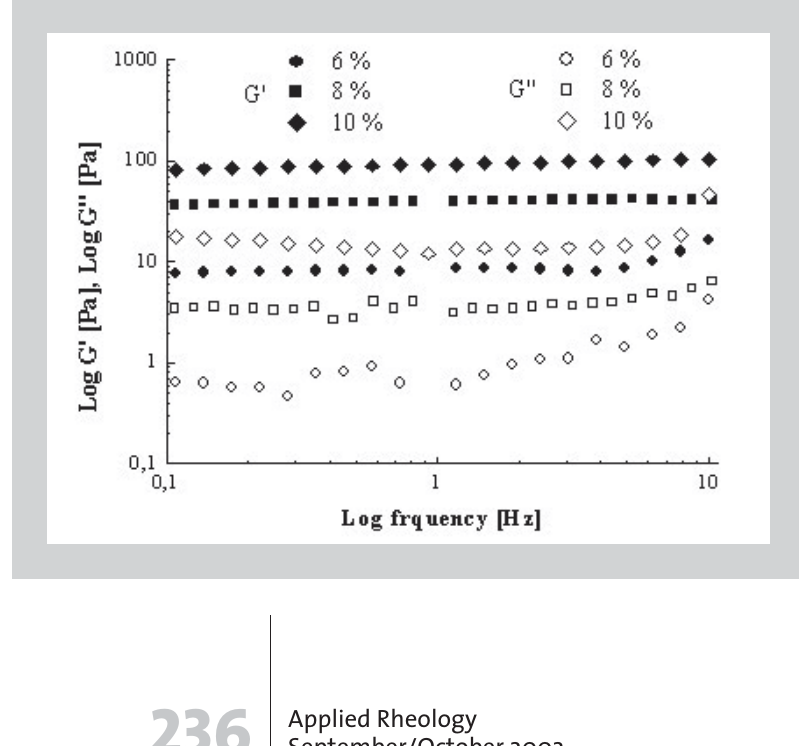
Figure 2: Dynamic experiments : variation of G’ and G’’ with frequency for three bentonite dispersions (6, 8 and 10